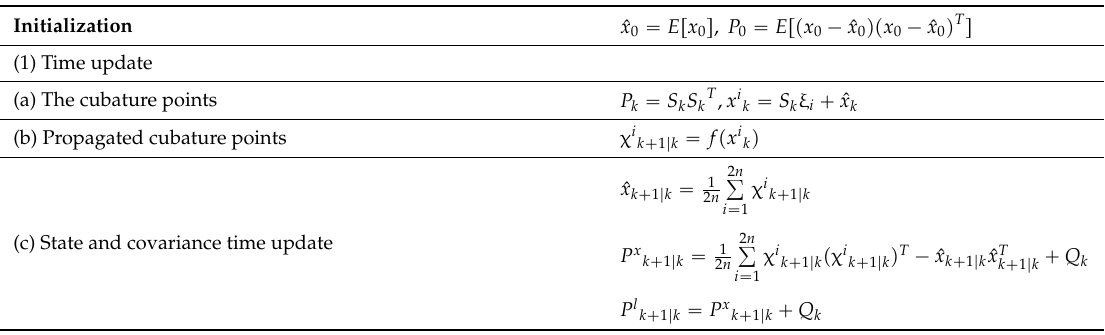
Table 2. Summary of strong tracking cubature Kalman filter (STCKF) algorithm.